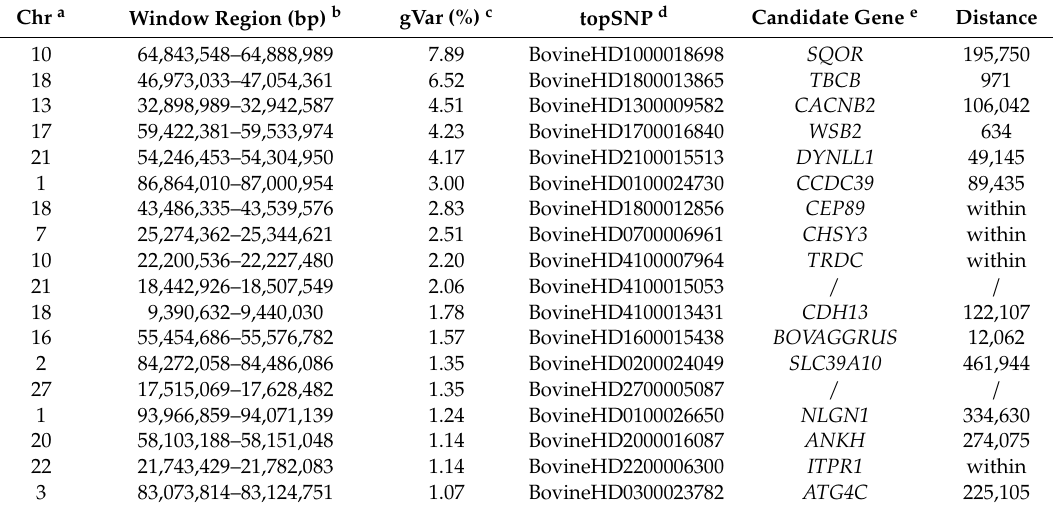
a Chromosomes; b Window position in Ensembl; c The proportion of the genetic variance explained by 20 adjacent SNP window; d The SNP that explained the largest proportion of genetic variance within each window (equal to the value of the 20 adjacent SNP window explained); e Candidate genes near the top